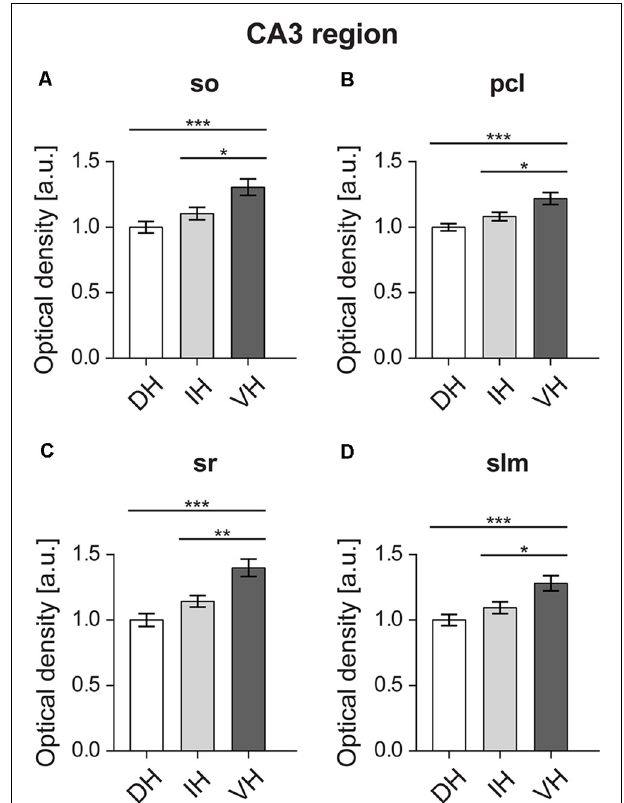
FIGURE 4 | In the CA3 region, the ventral component shows the highest D2R expression. All layers of the ventral CA3 region, namely the Stratum oriens (so) (A) , pyramidal cell layer (pcl) (B) , Stratum radiatum (sr) (C) , and Stratum lacunosum-moleculare (slm) (D) display high D2R levels compared to the dorso-intermediate CA3. Values expressed in arbitrary units (a.u.). Error bars indicate SEM. ∗ p < 0.05, ∗∗ p < 0.01, ∗∗∗ p <0.001. so, Stratum oriens; pcl, pyramidal cell layer; sr, Stratum radiatum; and slm, Stratum